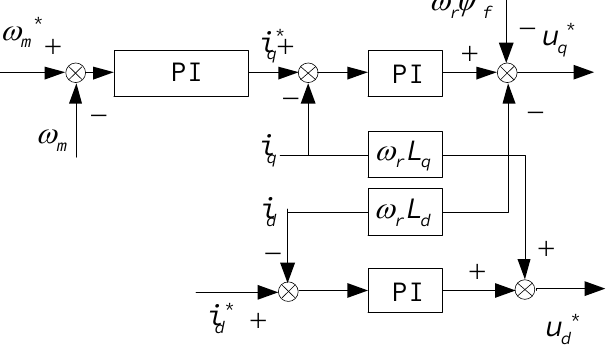
Figure 1. Control diagram of the generator side converter.